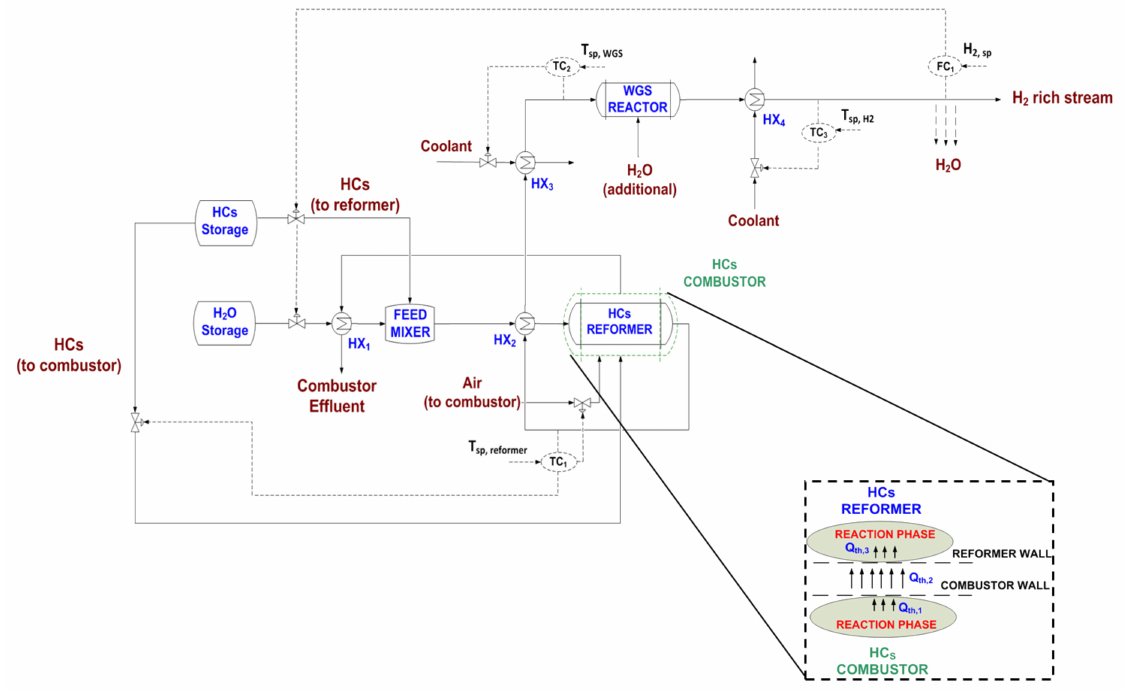
Figure 1. Coupled reforming / combustor system for H 2 production along with a distributed control